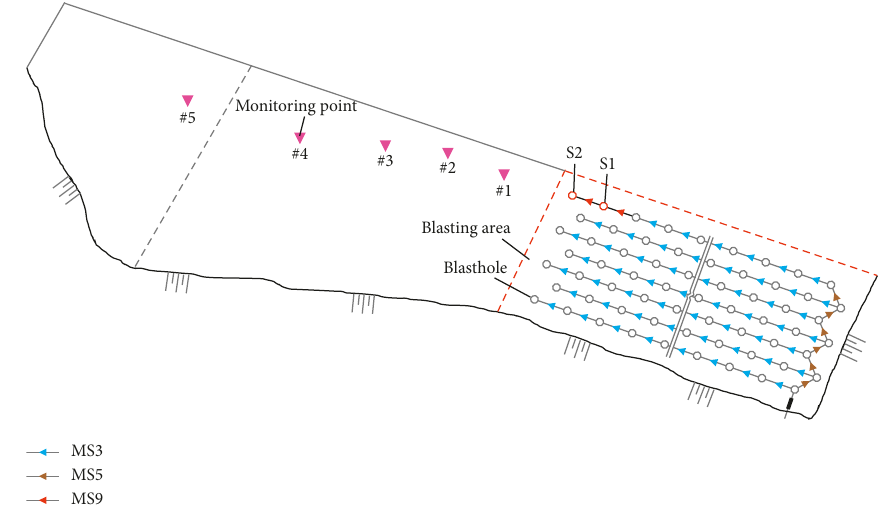
Figure 24: Layout of blastholes and vibration monitoring points in the production blasting